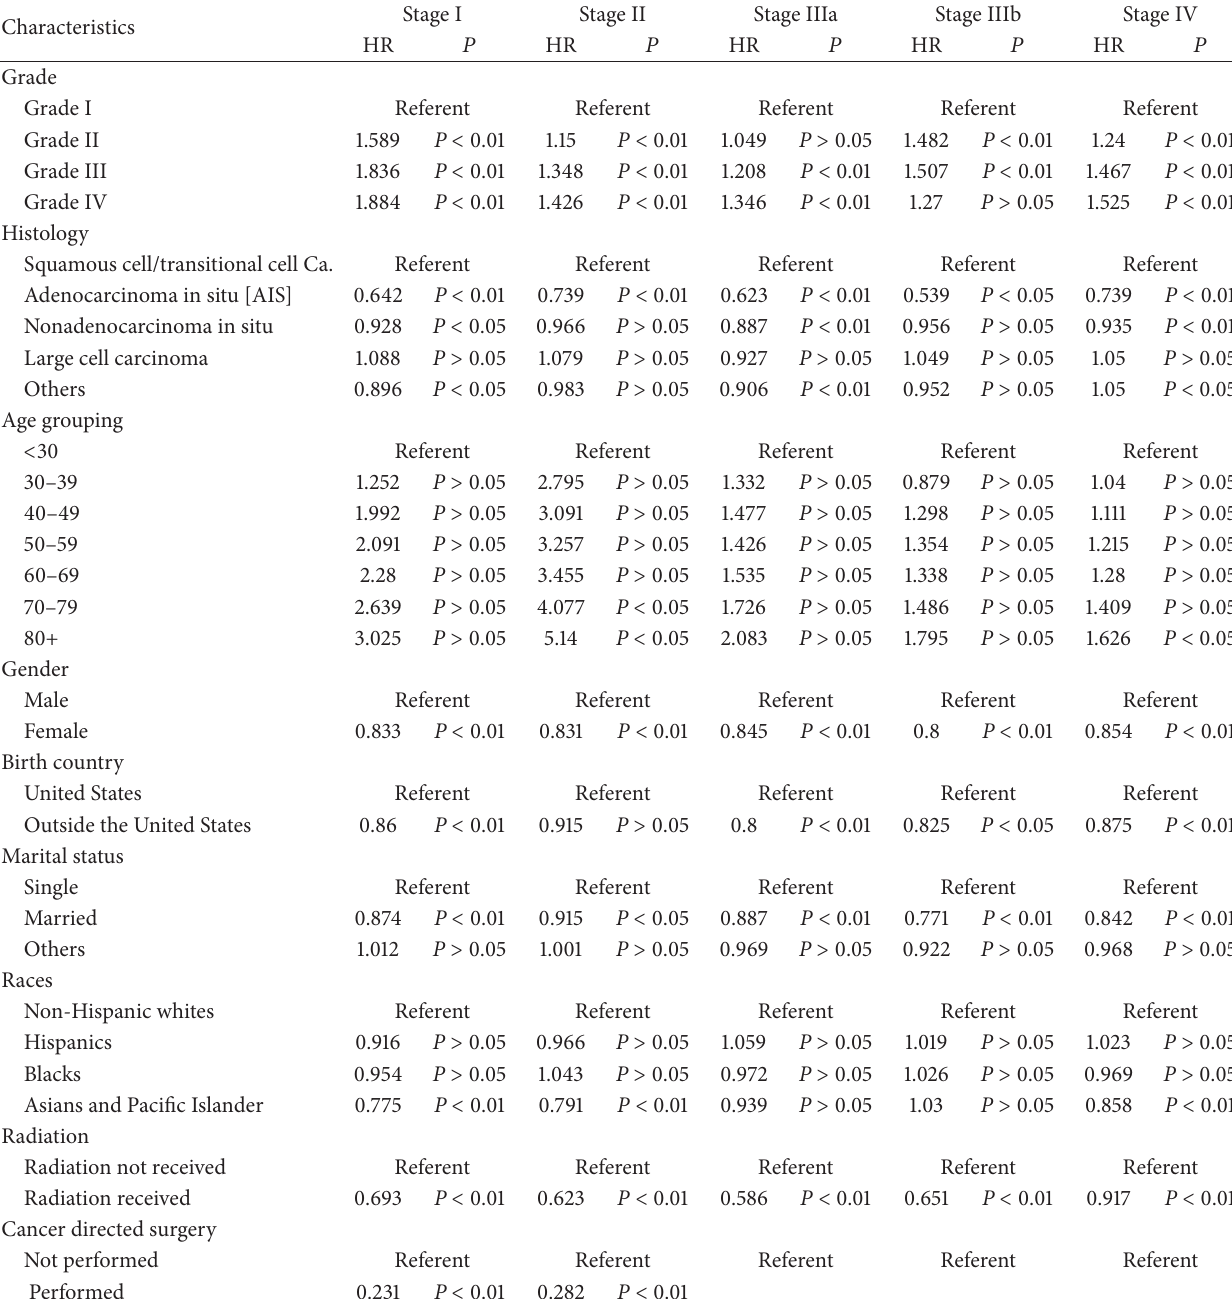
Table 3: Multivariate Cox proportional analysis used to ascertain the contributions of the demographic, clinicopathologic, and treatment features to the DSS among the different AJCC